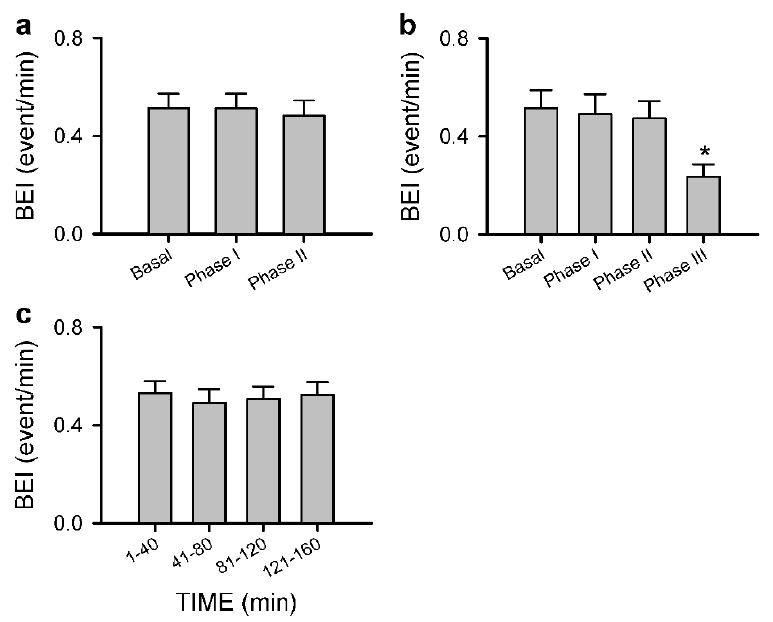
Figure 5. Common ( a ) and anomalous ( b ) response patterns of BEI to intrathecal administration of 80 μL of bupivacaine. Values for ( a ) are mean ± SEM from 33 animals (17 from Group 2 plus 16 from Group 3); and values for ( b ) are mean ± SEM of 15 animals (7 from Group 2 plus 8 from Group 3). * p < 0.05 versus data obtained under basal conditions in the post hoc Dunnett multiple- range analysis. ( c ) Insignificant changes of BEI under isoflurane alone without spinal anesthesia. Values are mean ± SEM of 14 animals from Group 4. No significance among all groups ( p > 0.05).